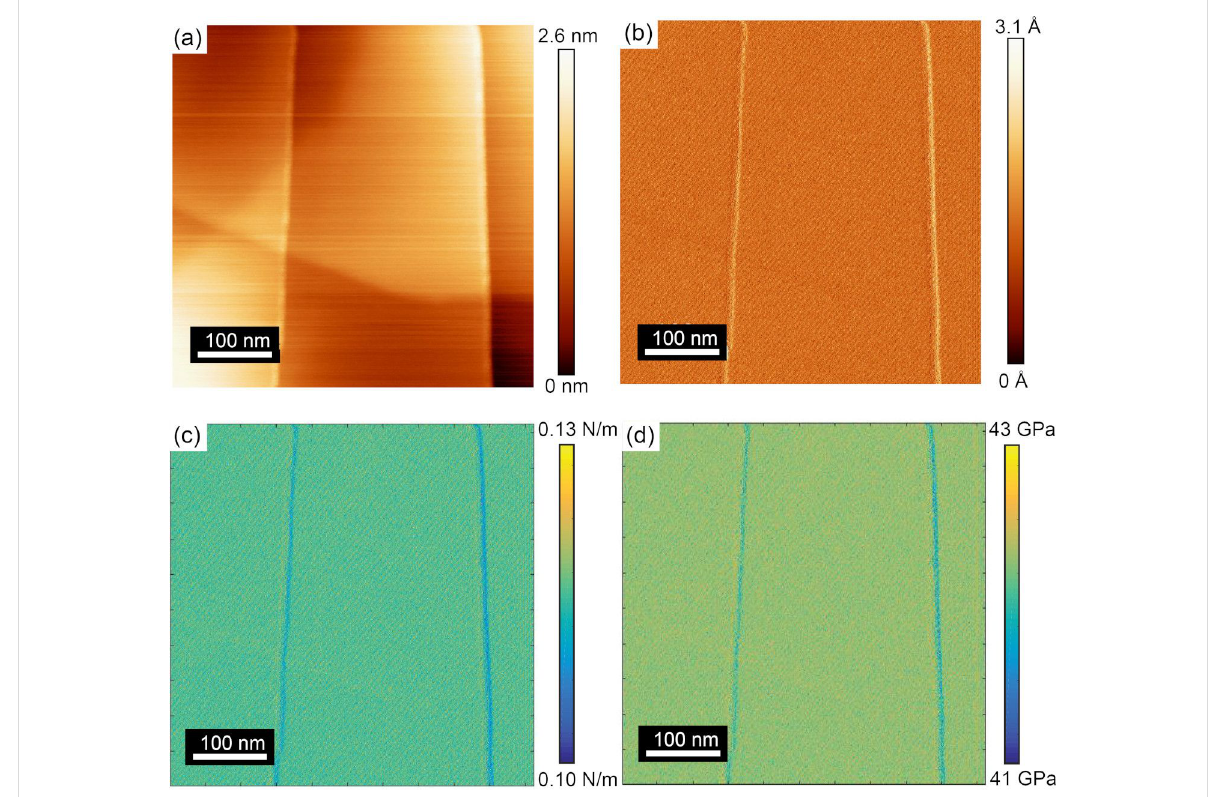
Figure 6: (a) AFM topographic map of a third area of the HOPG surface containing both uncovered and covered steps acquired with FMM. (b) Corre- sponding amplitude map (1.5 kHz modulation frequency) measured on the surface. Calculated (c) contact stiffness and (d) elastic modulus maps of the surface. The data presented in this figure were acquired with tip